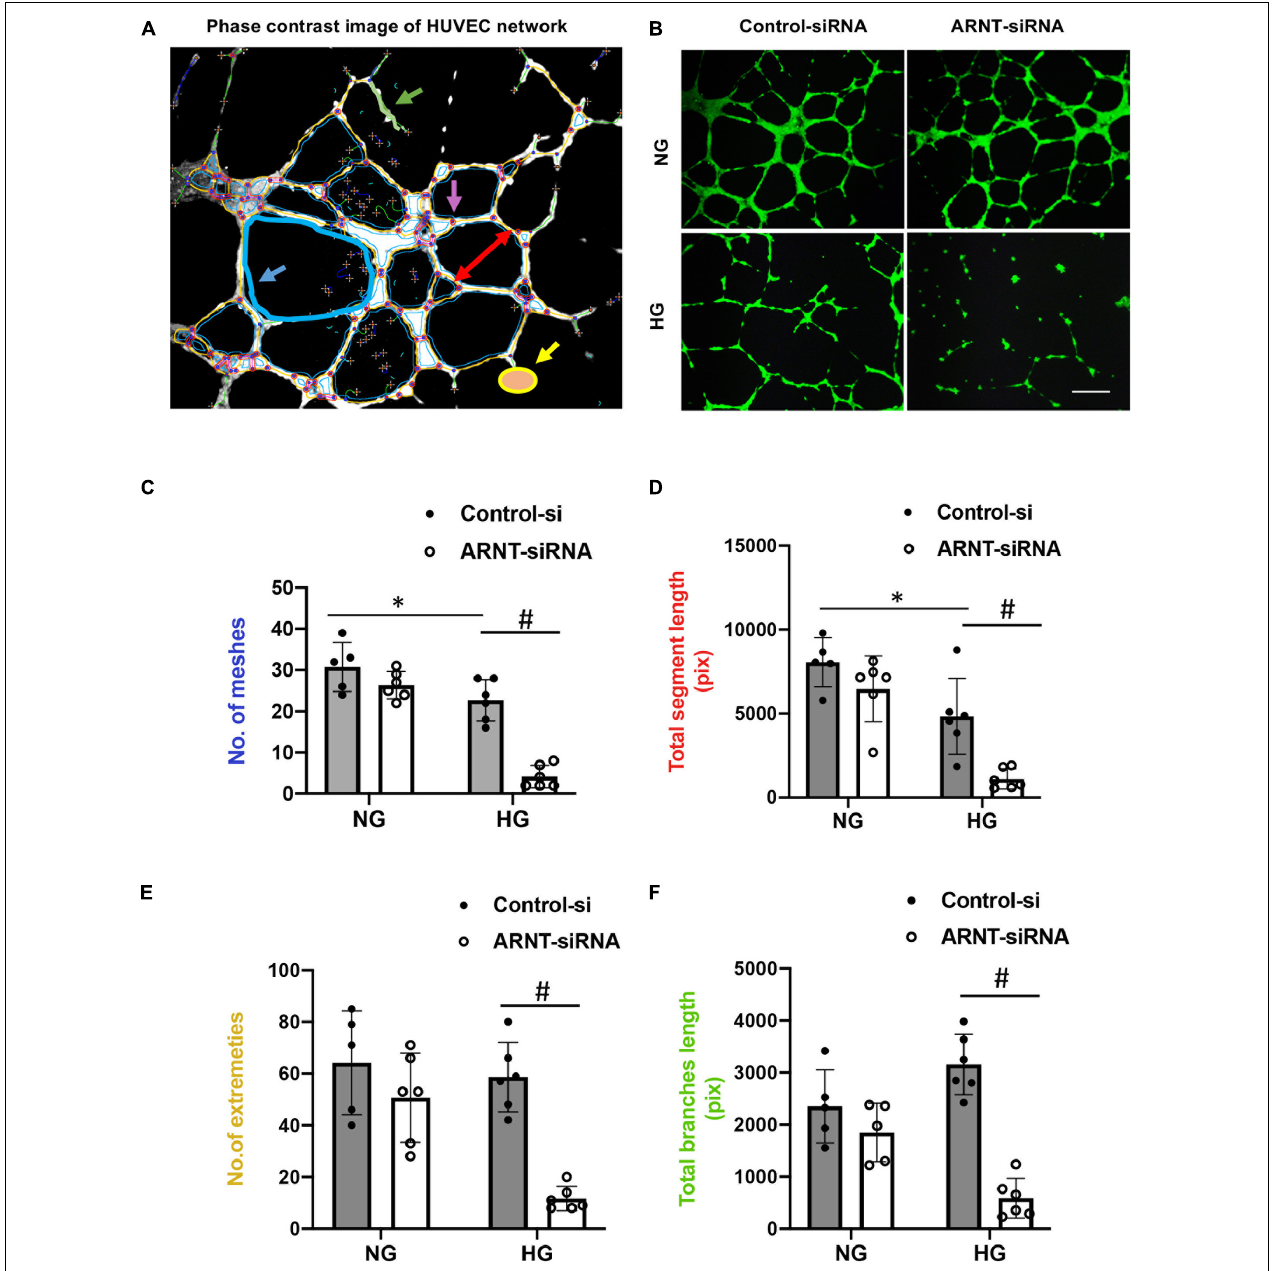
FIGURE 4 | The effects of ARNT knockdown on tube formation in cultured human umbilical vein endothelial cells (HUVECs). Cells were plated on Matrigel pre-coated 24-well plates that were transfected with either ARNT-siRNA or control-siRNA followed by high glucose (HG) and control exposure (NG, identical concentrations of mannitol as an osmotic control group) for an additional 48 h. (A) Representative image of HUVEC network, analyzed by the angiogenesis analyzer for Image J. The picture shows meshes (blue), extremities (yellow), branches (green), and segment length (red) as indicated. (B) Images of capillary-like tube formation, which mature by 6–16 h. Photomicrograph shows the effect of 35 mM high glucose exposure on tube formation with and without ecARNT knockdown (Scale bar = 200 µ m). Summary of analysis is shown. (C) Number of meshes. (D) Total segment length. (E) Number of extremities. (F) Total branch length. Data are presented as the mean ± SEM ( n = 5–6). ∗ P < 0.01 versus Control-si (NG), # P < 0.01 vs. Control-si